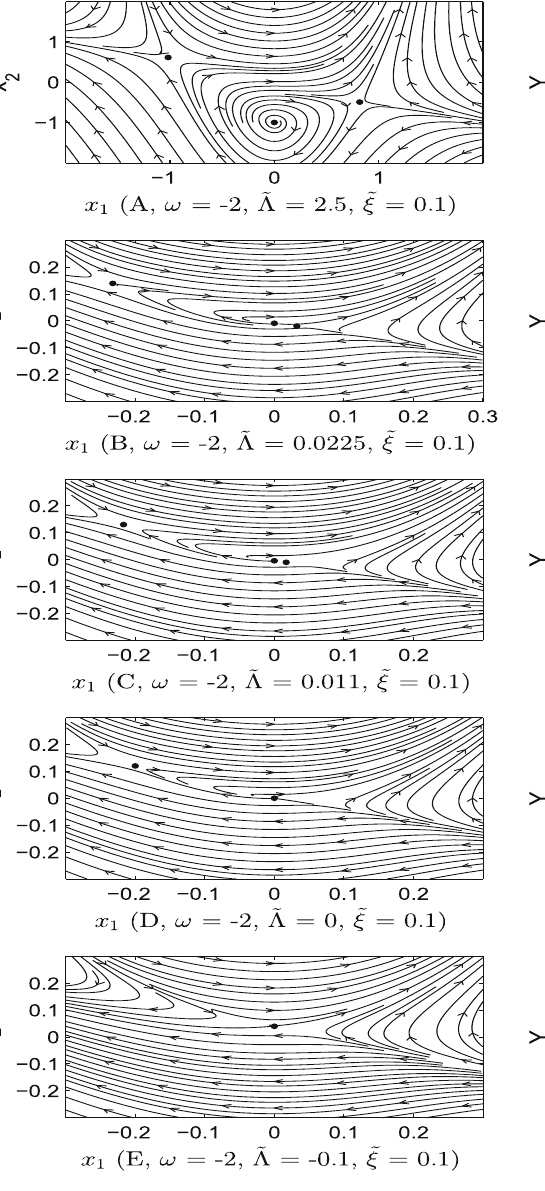
Fig. 15 Uncompact (left panel) and compact (right panel) phase por- tively denote the dimensionless ˜ H and ˜ ρ as defined in Eq. (7). X and Y are the coordinates on the Poincaré sphere as defined in Eq. (47). The traits when viscosity is included, ˜ ξ = 0 . 1. Representative cases are ω = − 2 while ˜ (cid:4) = 2 . 5 , 0 . 1575 , 0 . 011 , 0 and − 0 . 1. x dotted circles represent fixed 1 and x 2 respec-